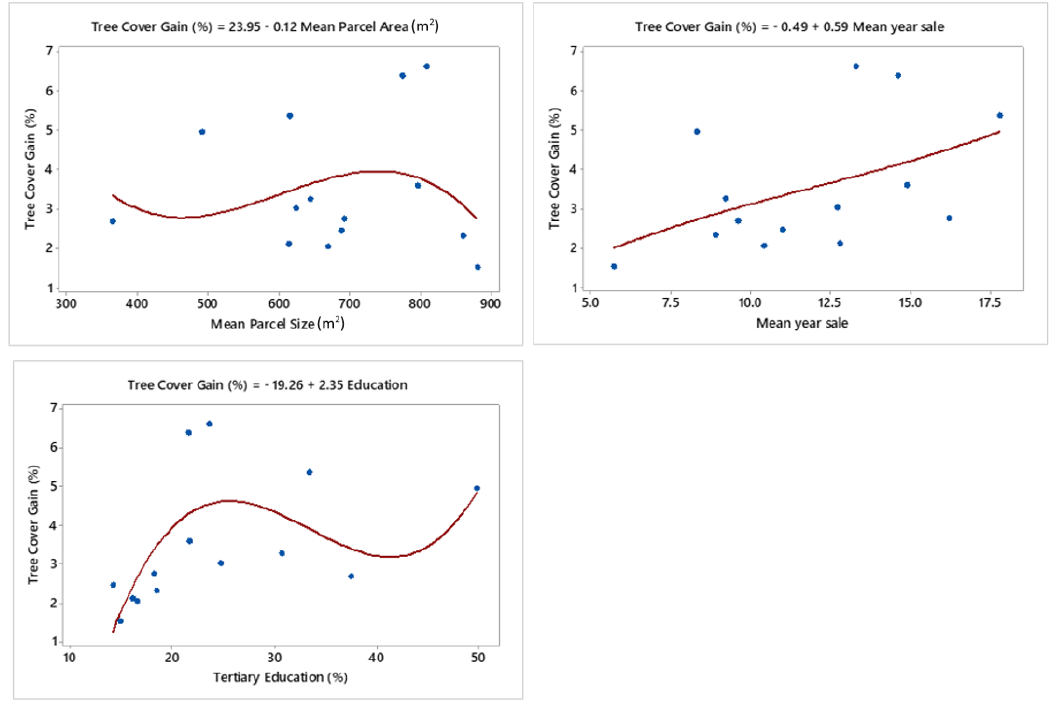
Figure 14. Sample level tree cover gain versus mean parcel area (m 2 ), mean number of years between